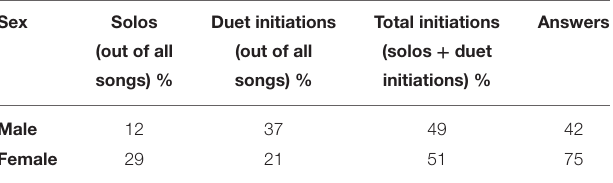
FIGURE 3 | Frequency (A–C) and temporal (D) measurements that were statistically significantly different between female (F) and male (M) song ( p < 0.01; see Table 4). Note, however, the broad range overlap for all four parameters. Box and whisker plots show the entire distribution of the data, including median, 1st and 3rd quartiles, all data within 1.5 times the Inter Quartile Range beyond the 1st and 3rd quartiles, and